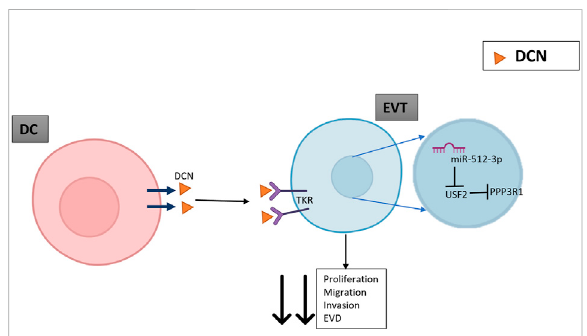
FIGURE 6 A schematic indicating the possible role of DCN mediated upregulationof PPP3R1 .DCNreleasedbydecidualcells(DC)binds as a negative regulatory ligand to multiple tyrosine kinase receptors (TKR) on extravillous trophoblasts (EVT) to restrain migration, invasion, proliferation and endovascular differentiation (EVD). DCN also induces expression of miR-512-3p (binding partner unknown), which paradoxically upregulates its target PPP3R1 . This is explained by its binding to an intermediary transcription factor USF2 which downregulates the expression of its target PPP3R1 and results in decreased EVT proliferation, migration, and endovascular